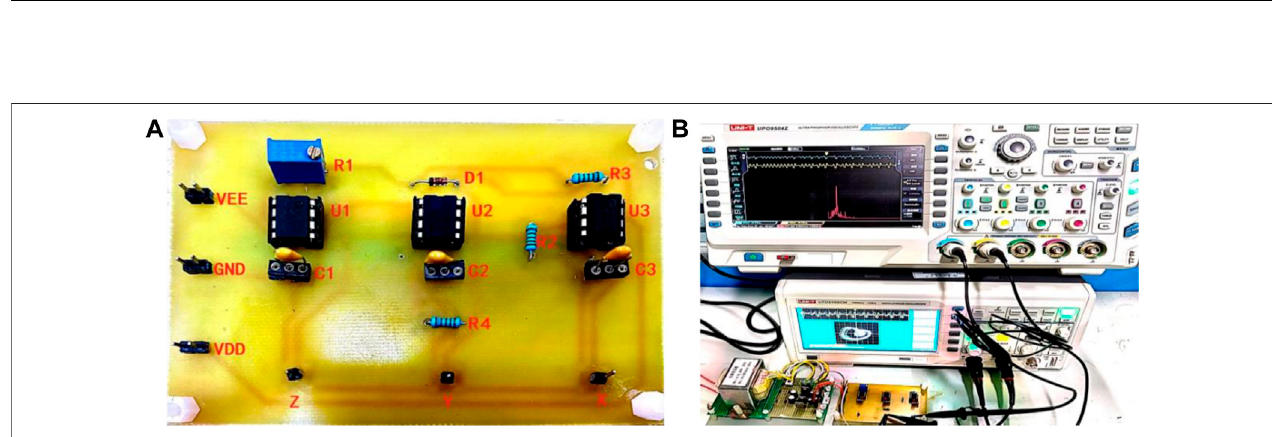
FIGURE 6 | Actual circuit implementation with COFAs. (A) Etched circuit board. (B) Actual experimental test with UNI-TUTD2102CM and UNI-T UPO9504Z.